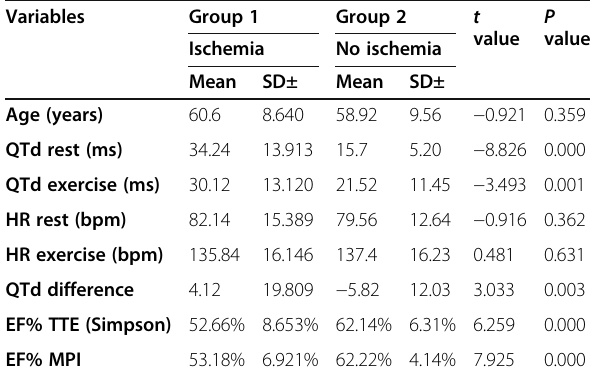
Table 2 Comparison between both groups regarding QT parameters Variables